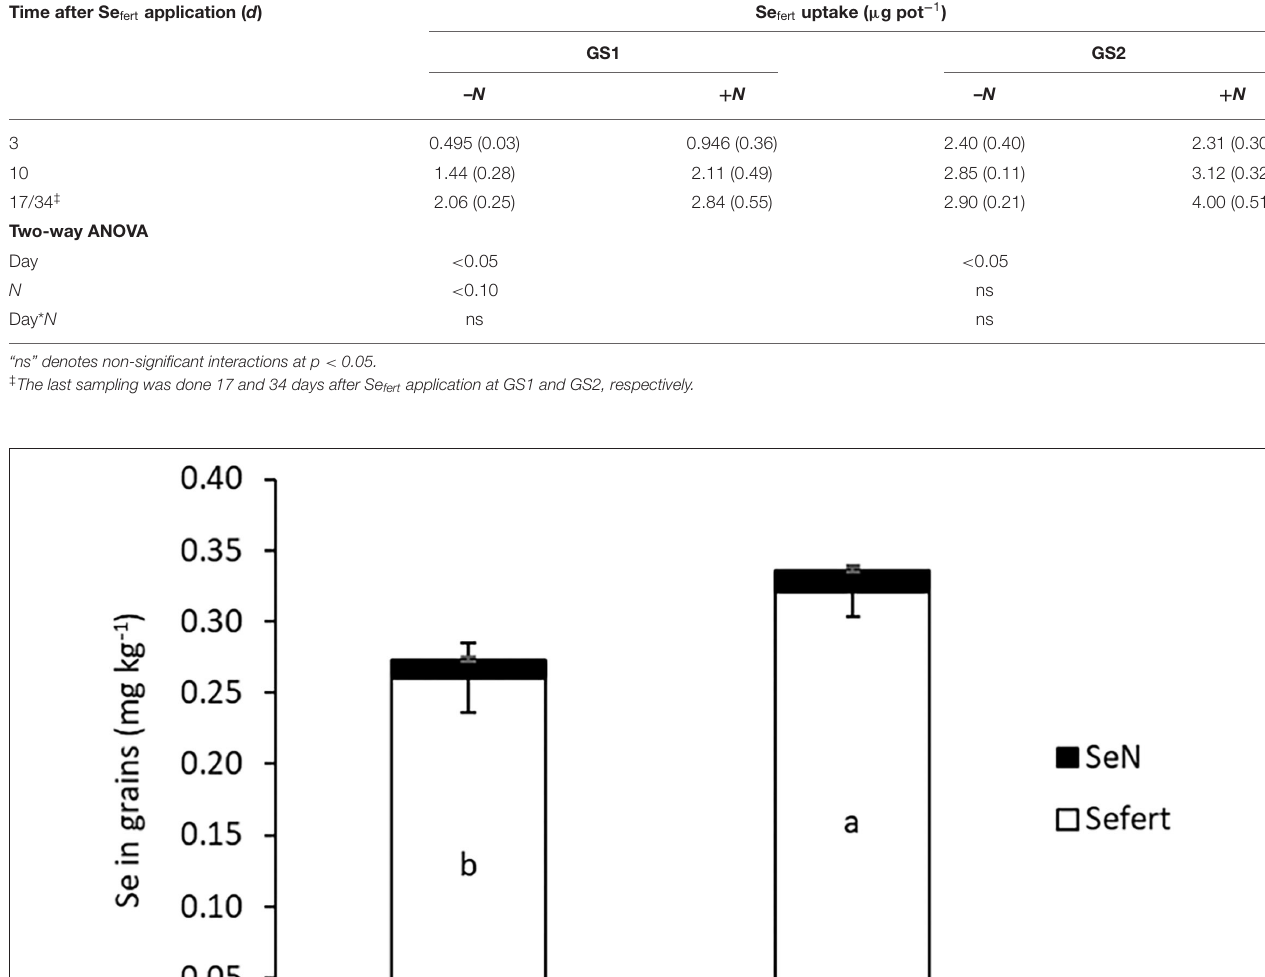
TABLE 3 | The influence of N inclusion with foliar Se solutions and harvest time on the accumulation of Se from the fertiliser (Se fert ) in the aboveground biomass (foliar-treated leaves excluded) (SE in brackets; n = 4). Time after Se fert application ( d )